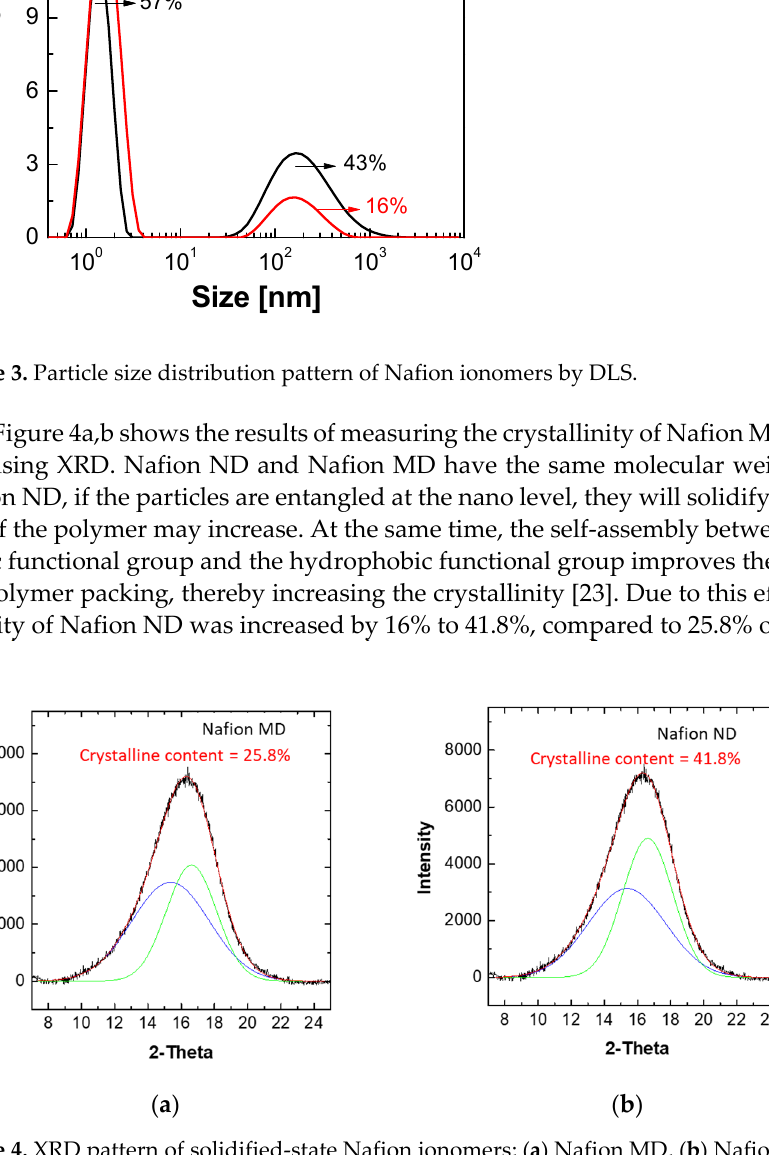
Figure 4. XRD pattern of solidified-state Nafion ionomers; ( a ) Nafion MD, ( b ) Nafion